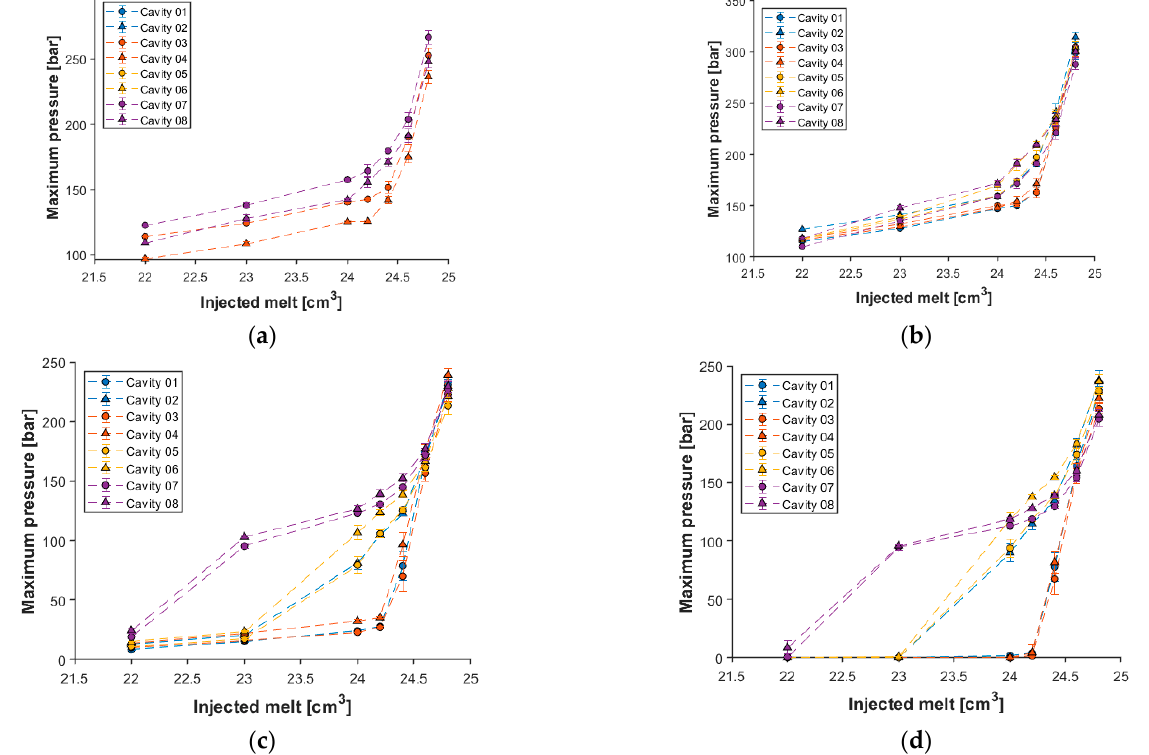
Figure 8. Maximum pressure for each cavity based on: ( a ) tertiary channel sensors; ( b ) pre-gate sensors; ( c ) post-gate sensors; ( d ) end-of-cavity sensors.